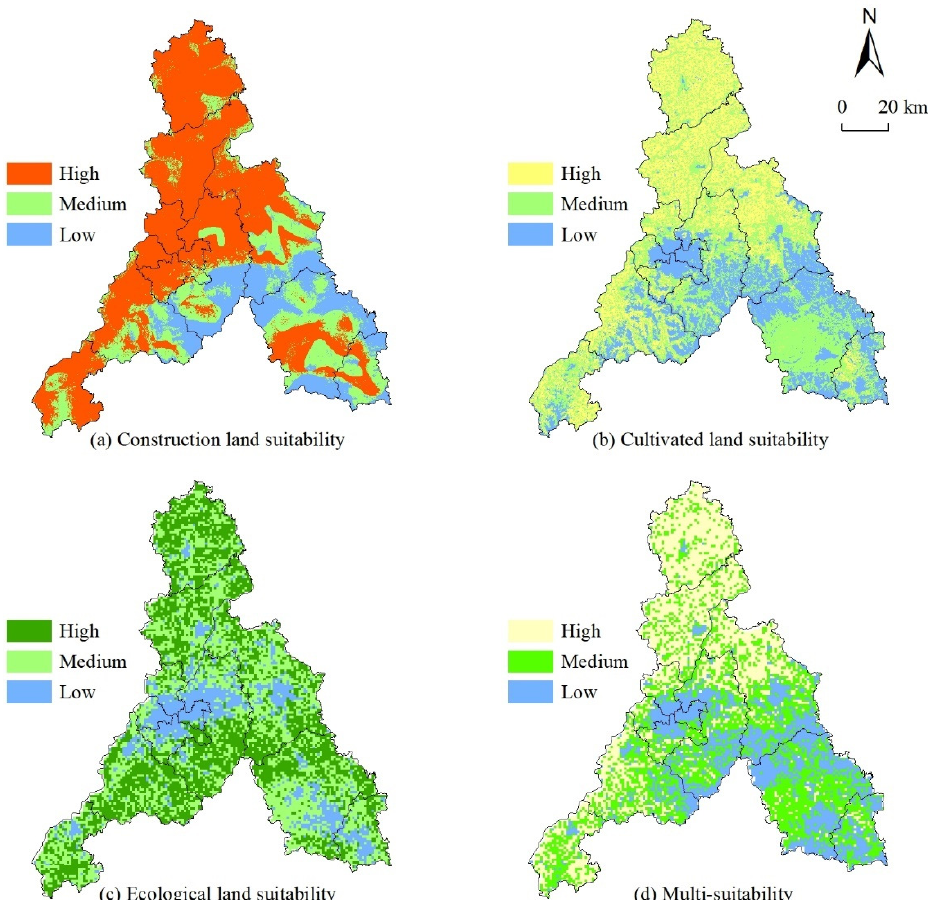
Figure 3. Spatial distribution of land use